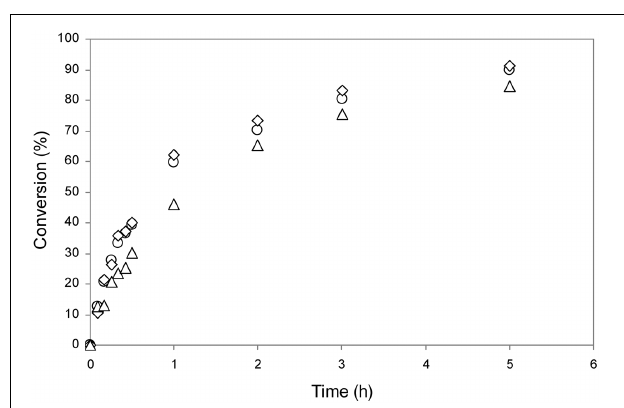
FIGURE 7 | Analysis by HPLC of biodiesel (FAEEs) conversion from a FFA mixture using mCLEA-CALB. The reaction conditions were the same as indicated in Figure 6 . Conversion of oleic acid (triangles), linoleic acid (diamonds), and linolenic acid (circles).